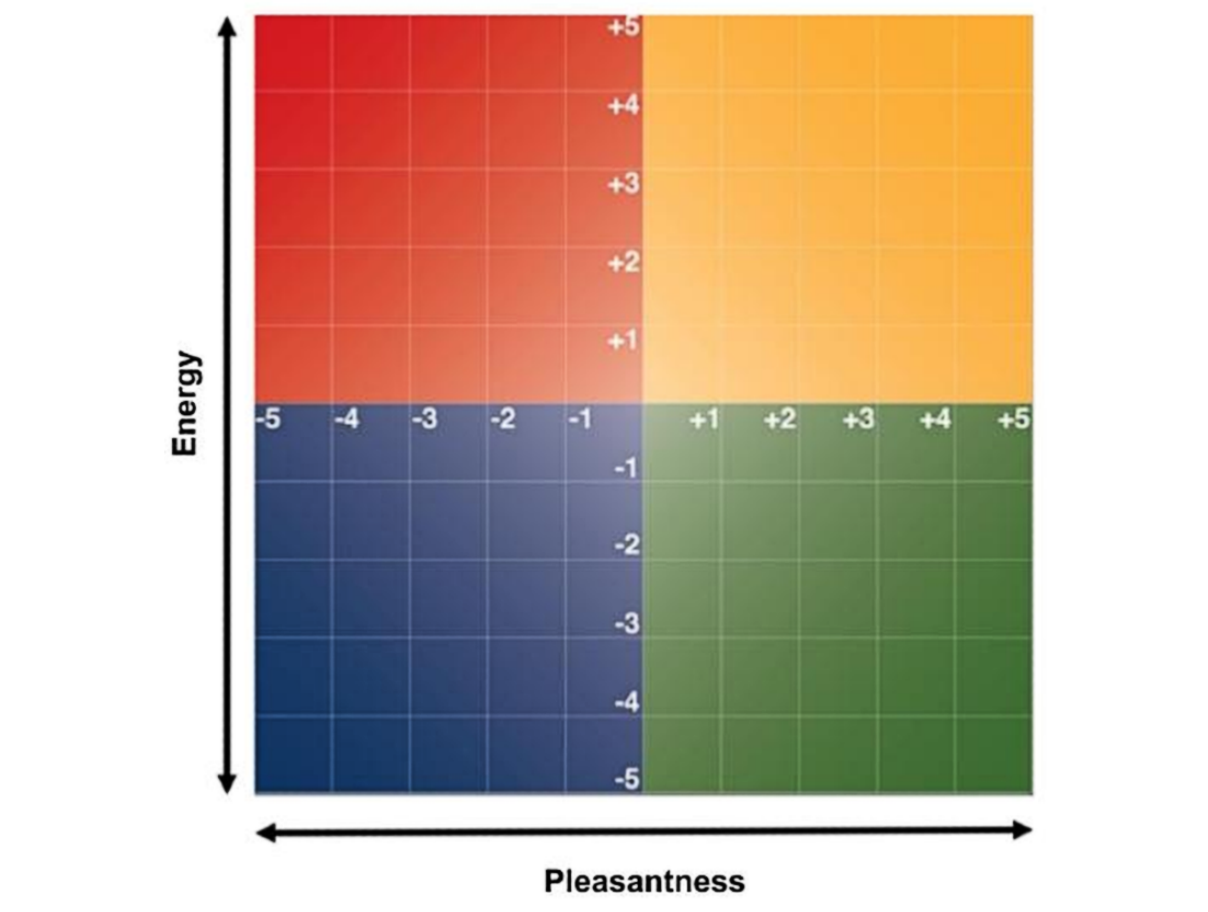
Figure 2. Yale Mood Meter (see the main text for a description and references). A 2 dimensional framework which classifies emotions by their pleasantness (x-axis) and energy (y-axis). Yellow and green quadrants are favorable states whereas red and blue quadrants are